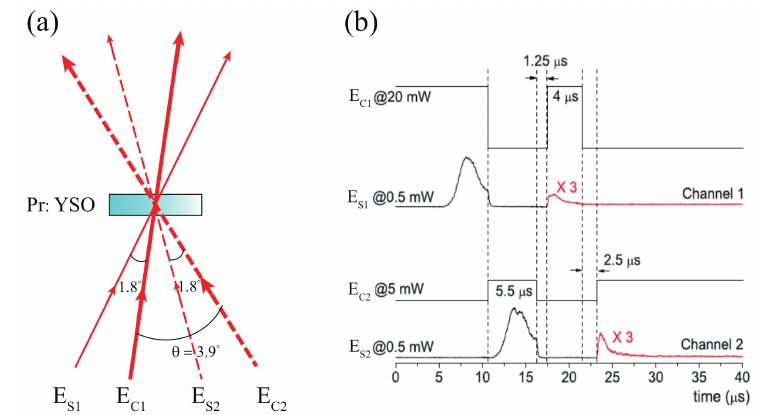
Figure 4. ( a ) is the schematic diagram of the angular multiplexing storage of light pulses in Pr:YSO crystal based on the EIT effect. Here, θ is the angular distance between two neighboring channels; E C 1 , E S 1 and E C 2 , E S 2 represent the coupling and the signal pulses for channel 1 and channel 2, respectively. ( b ) demonstrates the angularly addressable two-channel optical buffer memory based on the angular multiplexing light pulse storage technique in Pr:YSO crystal under the EIT condition. The angular distance between two channels was set to be θ = 3.9 o , which is much larger than the angular resolution of the atomic coherence gratings recorded in a 3-mm Pr:YSO crystal. Note that the strength of the retrieved signal pulses in both channels has been multiplied by a factor of 3 for clarity. Figure 4b was adapted from reference